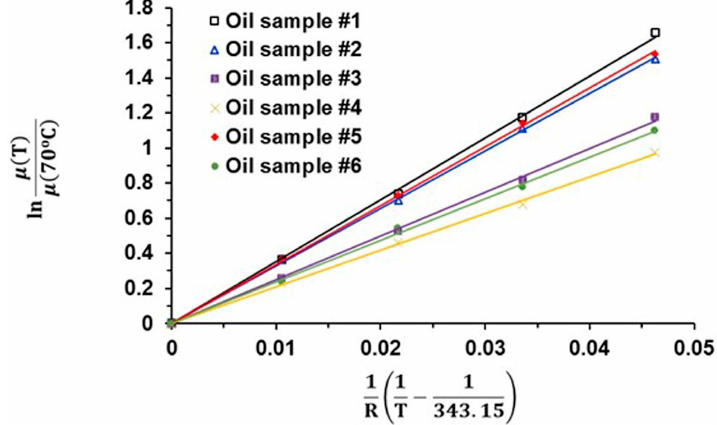
Figure 7. Plots in terms of the Arrhenius equation for heavy oil samples.